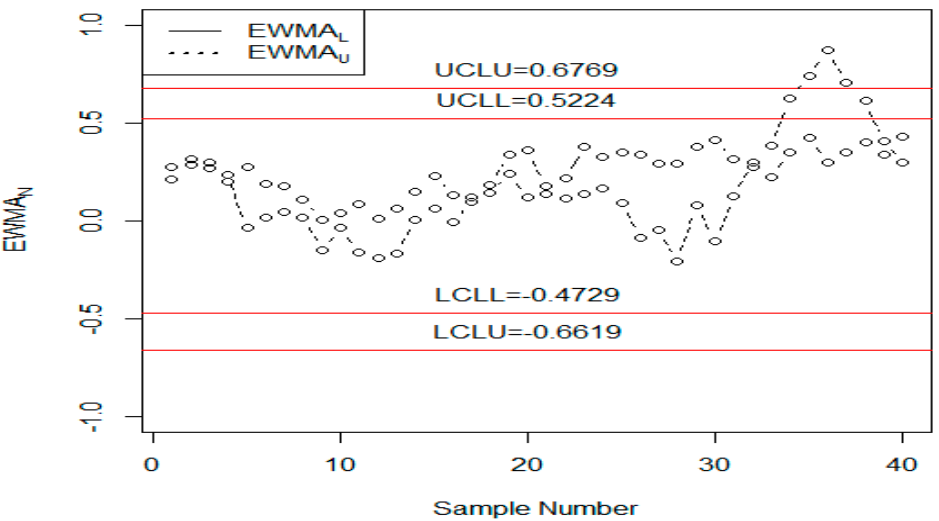
− NEWMA chart for the simulated Figure 1. The S 2 N Figure 1. The 𝑆 (cid:3015)(cid:2870) − 𝑁𝐸𝑊𝑀𝐴 chart for the simulated data.